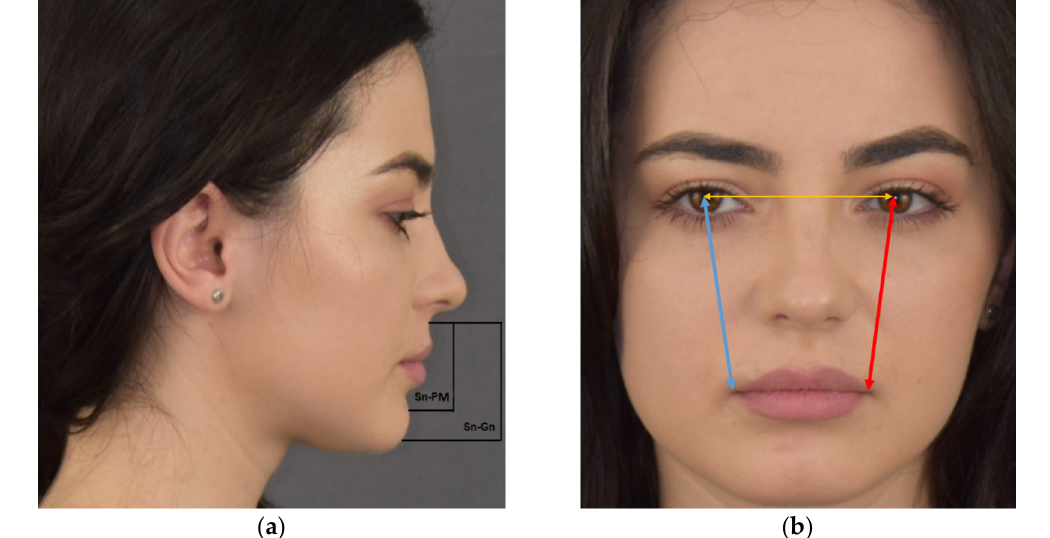
Figure 2. Anthropometric measurements in maximum intercuspation position: ( a ) Subnasion [Sn] to Prementon [PM] (Sn–PM), and Subnasion [Sn] to Gnathion [Gn] (Sn–Gn); ( b ) right pupil [Pu] to right buccal commissure (chelion [Ch]) (Pu–Ch_r), and left pupil to left buccal commissure (Pu–Ch_l).